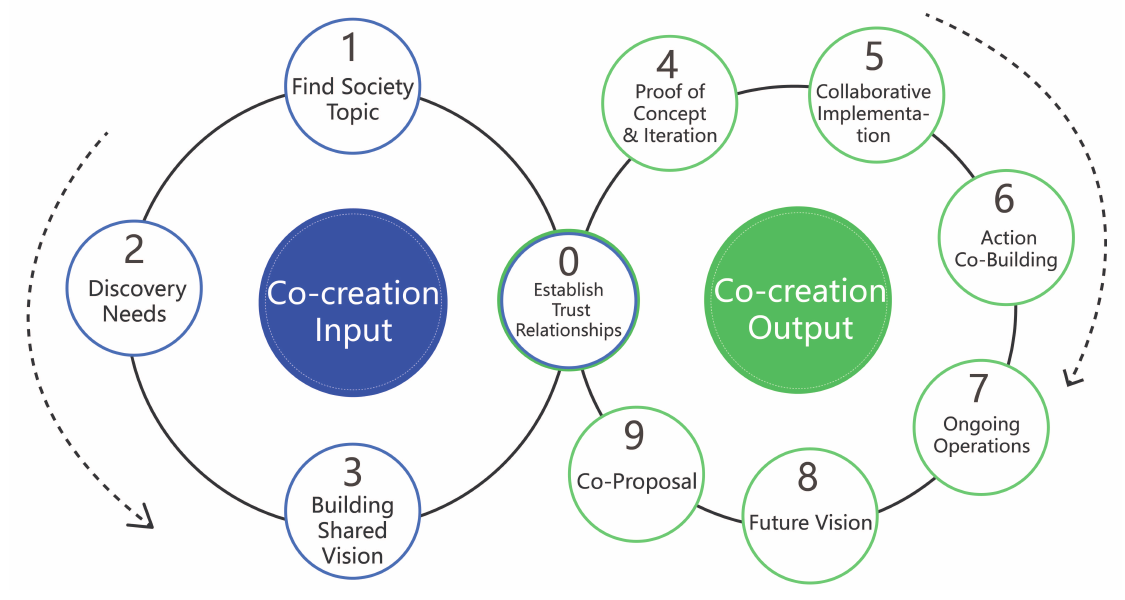
Figure 10Figure 10. Co-creation method